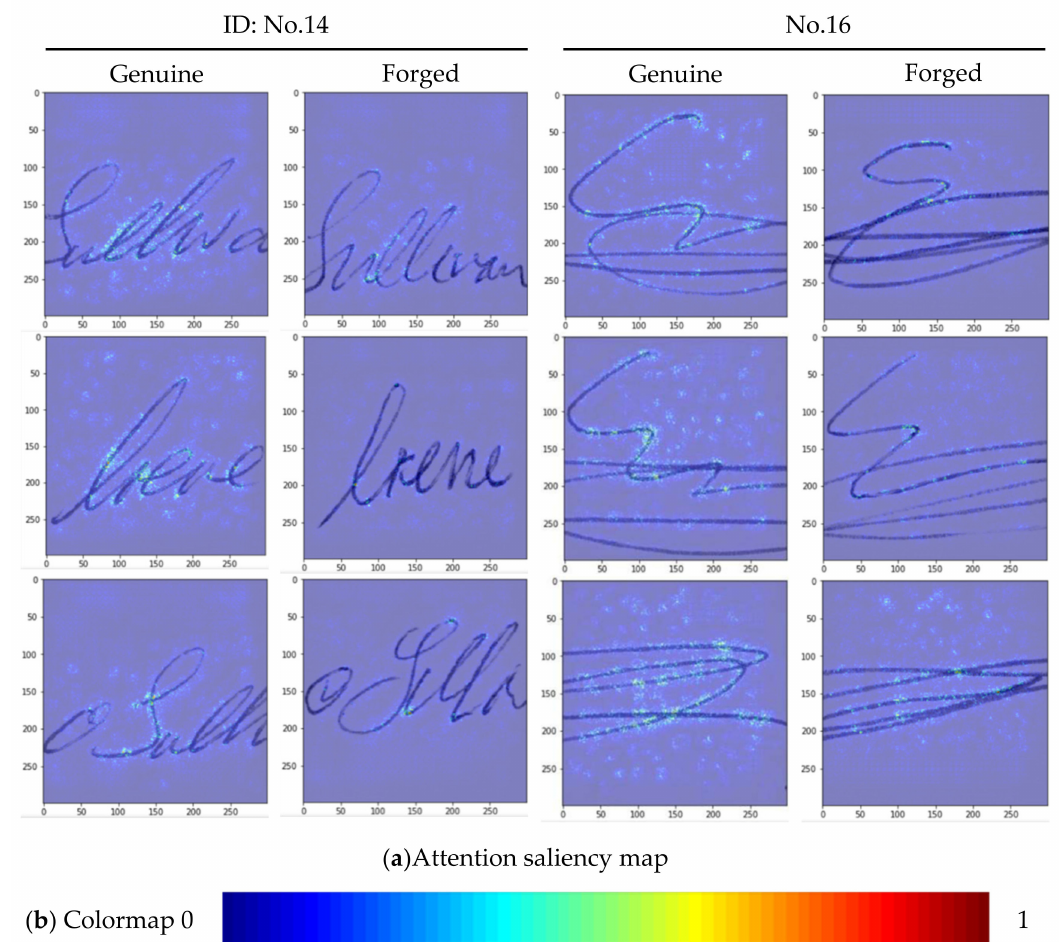
Figure 5. Saliency maps for the output layer of CNN networks. ( a ) Attention saliency maps for the signature sub-image blocks. ( b ) The colormap contains values between 0 and